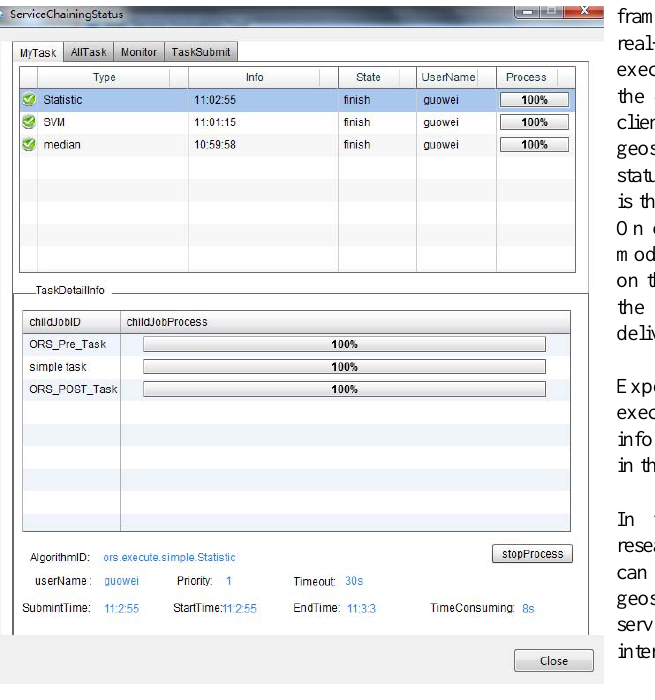
Figure 5. Final status